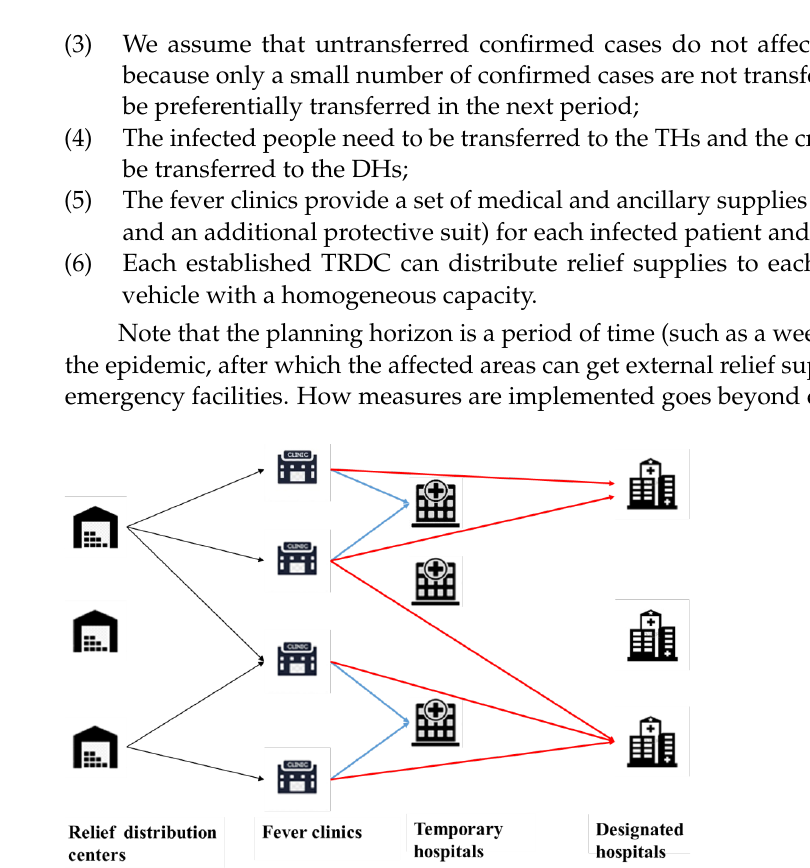
Figure 1. Patient transfer and relief distribution network in lockdown area of epidemic. In Figure 1, black arrows represent relief distribution. The blue arrows show the flows of infected people, and the red arrows show the flows of critical patients. The main